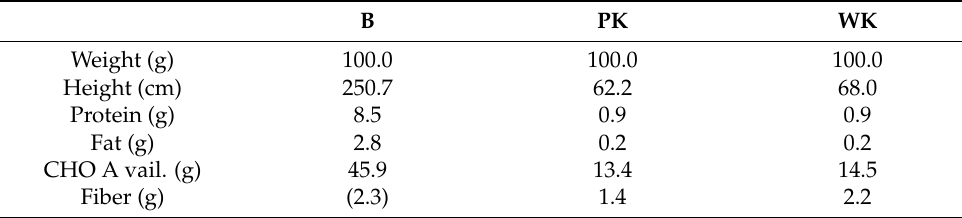
Table 2. Nutritional components and test-food